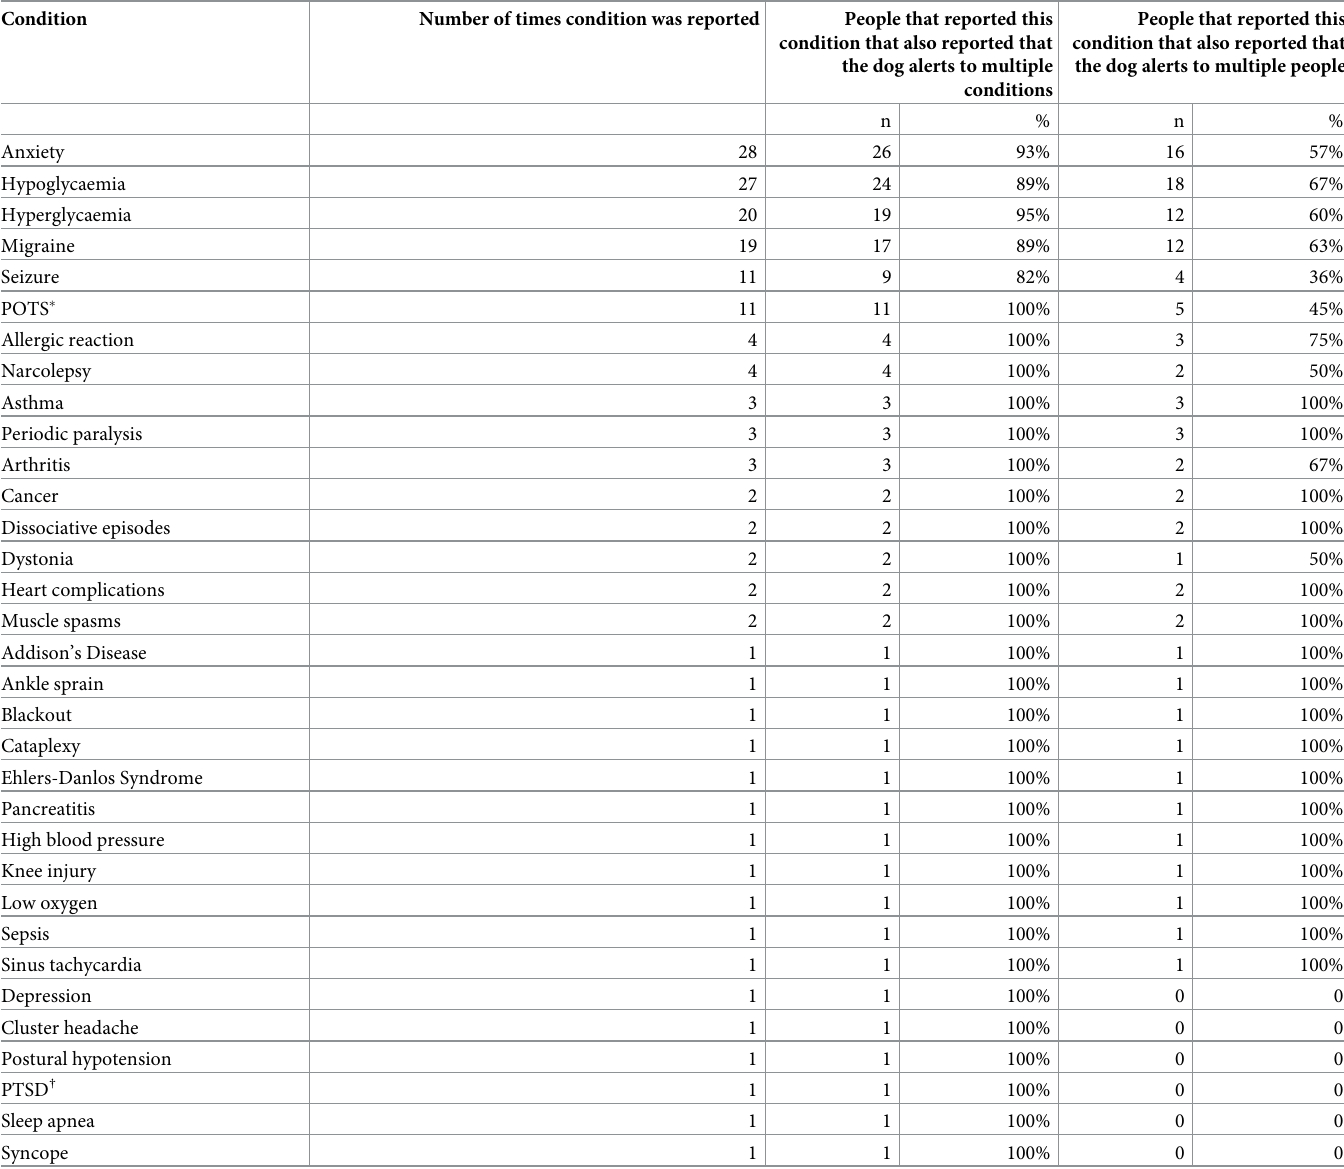
Table 2. Conditions to which owners report their dogs